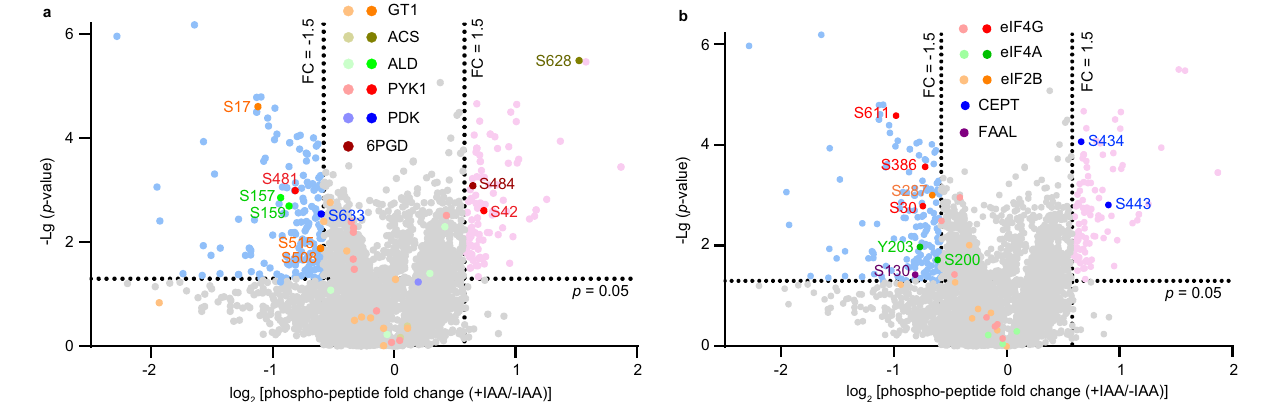
Fig.7|TgAMPK γ depletionaffectsthephosphorylationofmultipleproteinsin Toxoplasma . Alteration of the phosphorylation of selected sugar catabolism pro- teins ( a ) and biomass synthesis proteins ( b ) at indicated positions after TgAMPK γ degradation, as determined by phosphoproteomics on needle released AMPK γ - mAIDparasitespretreatedwithorwithoutIAAfor48h.Extractedparasiteproteins from n =3 sets of independent samples (each set contained one sample for IAA treated parasites and one for nontreated parasites) were trypsin digested and labeled with six plex tandem mass tags (TMT). Then, phospho-peptides were enriched by TiO 2 and IMAC, and quanti fi ed by LC-MS/MS. The abundance change